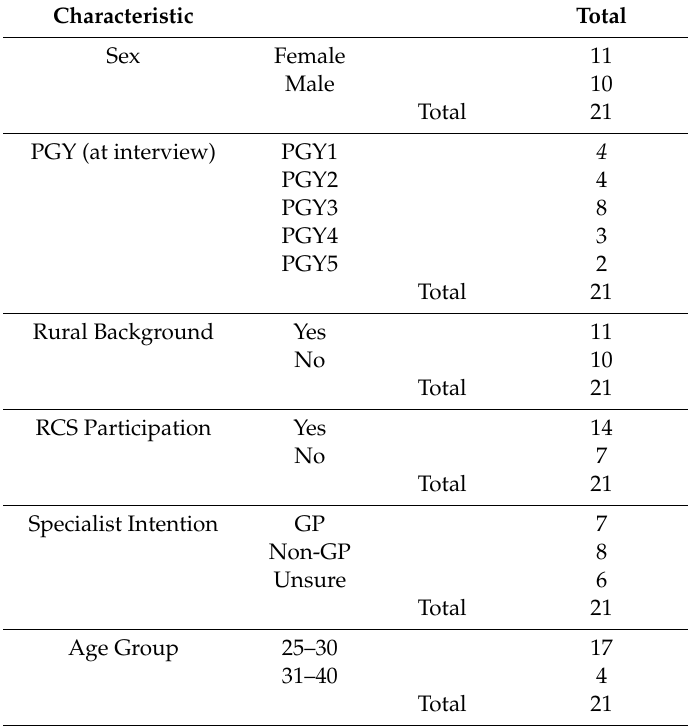
Table 1. Interview participants’ main sample